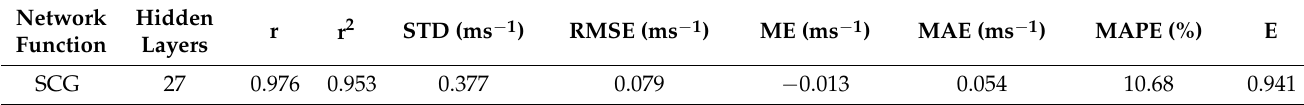
Table 5. Statistics of the ADCP-E prediction by SCG network.